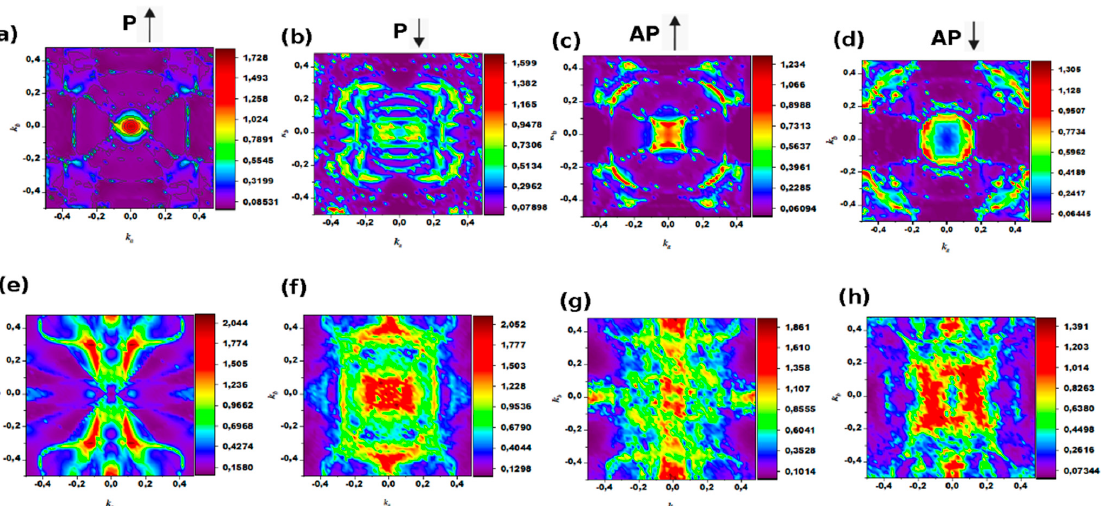
Figure 9. k || -resolved spin transmission spectra showing the majority (i.e. up) and minority (i.e. down) spin states, respectively, at the critical field of 0.1 Hartree a.u. in pMTJs based on monolayer hBN barrier in parallel (P) configuration ( a,b ) and antiparallel (AP) configuration ( c,d ), and in pMTJs based on monolayer MoS 2 in parallel configuration ( e,f ) and antiparallel configuration ( g,h ). In the AP configuration, the spin transmission corresponding to the majority